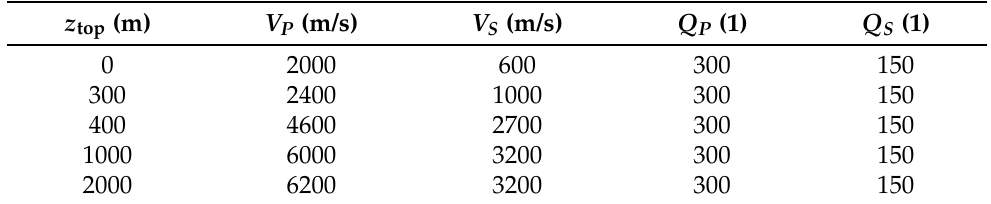
Figure 8. Regional crustal models proposed by Haslinger et al. [97] and refined by Hollender et al. [98]. Courtesy of Touhami [50]. Table 3. Mechanical properties of the geological profile proposed by [98] for the first 5 km down. V P is the pressure-wave velocity, V S is the shear-wave velocity, Q P and Q S are the quality factors for P- and S-waves,